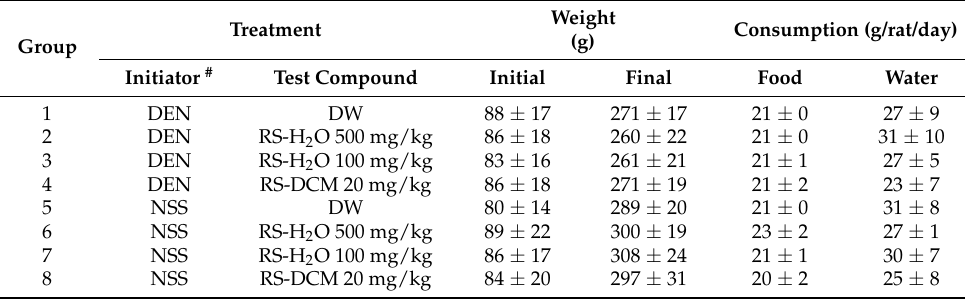
Table 5. Effects of RS on rat body weight (BW) and food/water consumption.